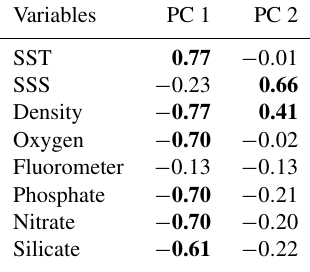
Table 3. Correlation matrix between principal component (PC) scores and the environmental variables. Significant Pearson corre- lation coefficients are indicated in bold ( p < 0 .